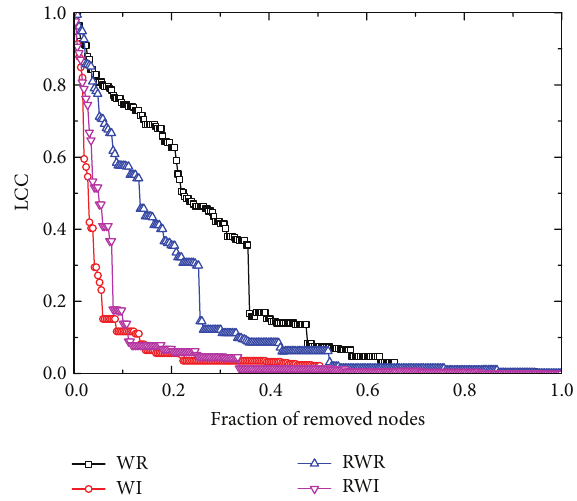
Figure 8: Performance changes of the largest connected cluster under different attack